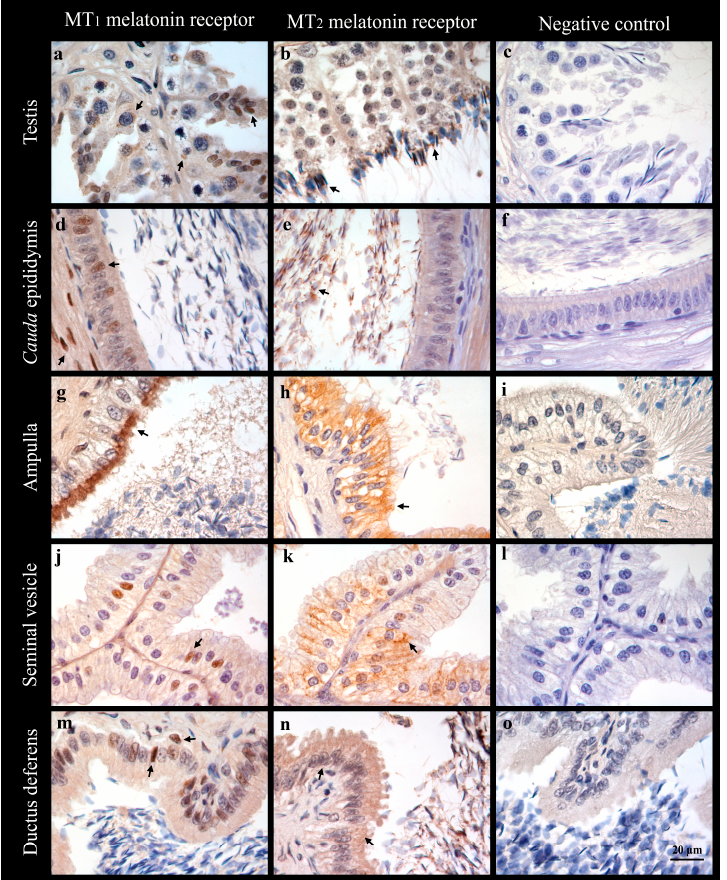
Figure 3. Immunohistochemical localization using the avidin-biotin complex technique of MT 1 (arrows in panels a , d , g , j and m ) and MT 2 (arrows in panels b , e , h , k , and n ) in testis ( a – c ), cauda epididymis ( d – f ), ampulla ( g – i ), seminal vesicles ( j – l ), and ductus deferens ( m – o ). Magnification 1000×. A 20 µm measurement bar is displayed in panel o . Negative controls are shown (panels c , f , i , l , and o ).